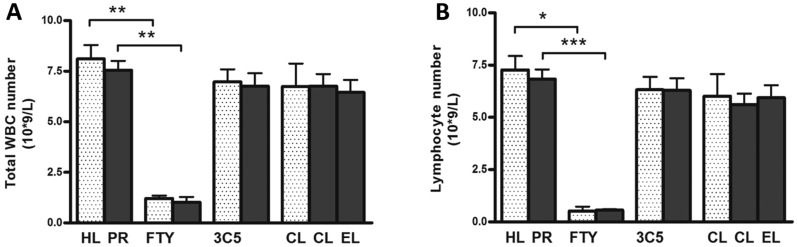
Number of total white blood cells (WBCs) and lymphocytes in the blood in both healthy and proteinuric rats at week 12. Total WBCs did not show any difference in healthy non-proteinuric compared to proteinuric rats (A). However, upon treatment with FTY720, the total WBCs dramatically decreased at week 12, in both healthy (white dotted bars) and proteinuric (black bars) groups. CL and IMC-3C5 did not show any effect. In order to see the effect of treatments on specific subsets of WBCs in the blood, we also measured the number of lymphocytes. FTY720 markedly reduced the number of lymphocyte in the circulation, even in healthy rats who received the drug. However, again the other two interventions did not have any effect on lymphocyte number in the blood circulation (B). HL, healthy; PR, proteinuric untreated; CL, clodronate liposome; EL, empty liposome; 3C5, anti-VEGFR3 antibody; FTY, FTY720. *P<0.05, **P<0.01, ***P<0.001.